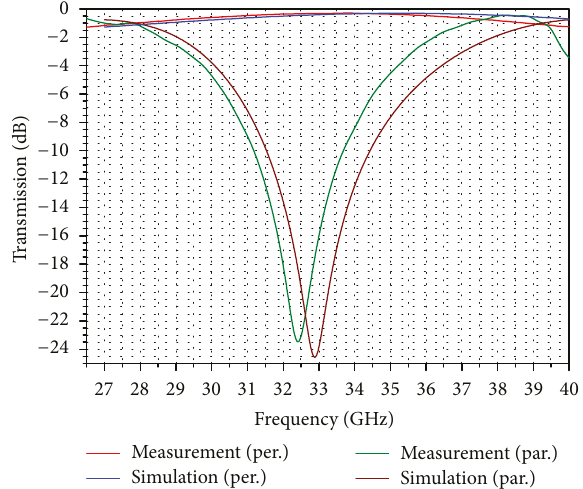
Figure 13: Measured and simulated (HFSS) transmission through the Ka-band structure.